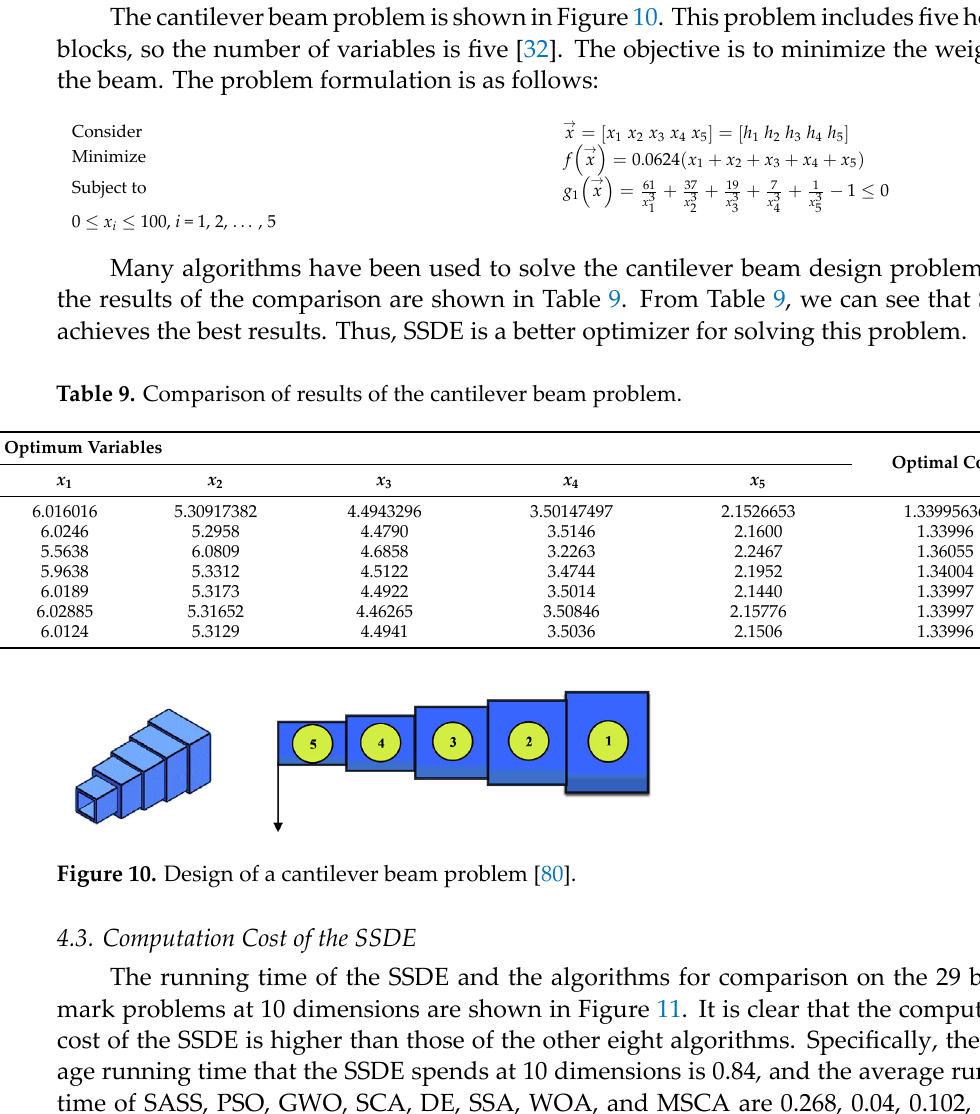
0 Figure 11. Running time comparison in 10 dimensions. 5. Conclusions This paper proposes a new swarm-based heuristic algorithm named SSDE. It divides the search process in search space into three phases. Each phase uses a different search rule. A non-linear self-adapting parameter is proposed. These strategies help the SSDE algorithm find the optimal solution more effectively. To verify its performance, we test 10 dimensions, 30 dimensions, and 50 dimensions of objective functions on the CEC 2017 test functions. Numerical results show that the SSDE is a competitive SASS variant in most functions. Compared with the other seven most popular algorithms, the SSDE exhibits stronger performance. In addition, the SSDE is also used to solve two popular practical